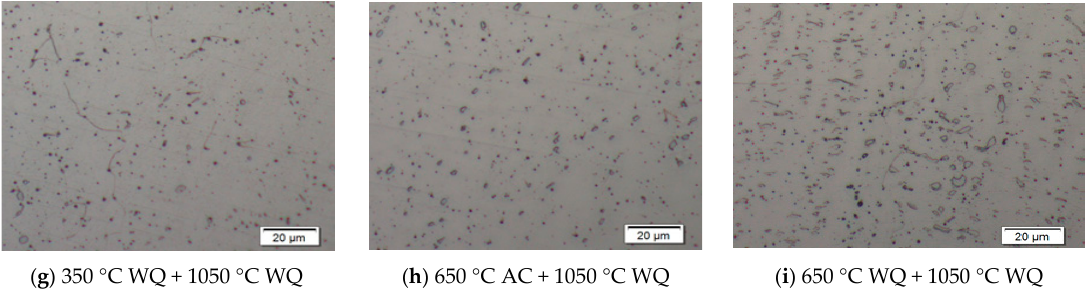
Figure 4. SEM micrographs of the fusion zone of various PWHT (350 °C, 650 °C and 1050 °C).